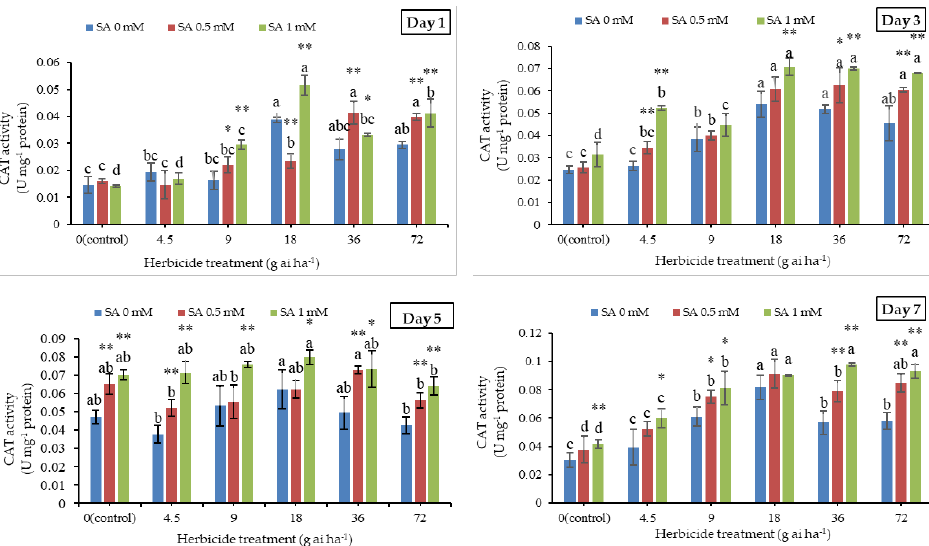
Figure 6. Changes in catalase (CAT) activity in the leaf tissues of wheat at 1, 3, 5, and 7 days after herbicide application at different rates. The leaves were pre-treated with different concentration of salicylic acid (SA) 3 days prior to herbicide application. The bars represent the treatment mean ± SD ( n = 4), and the bars with different lower-case letters were significantly ( p ≤ 0.05) different , according to the Duncan ’ s test. Asterisks indicate significant difference between the herbicide only and herbi- cide with each concentration of SA, according to the Independent Samples t -test.